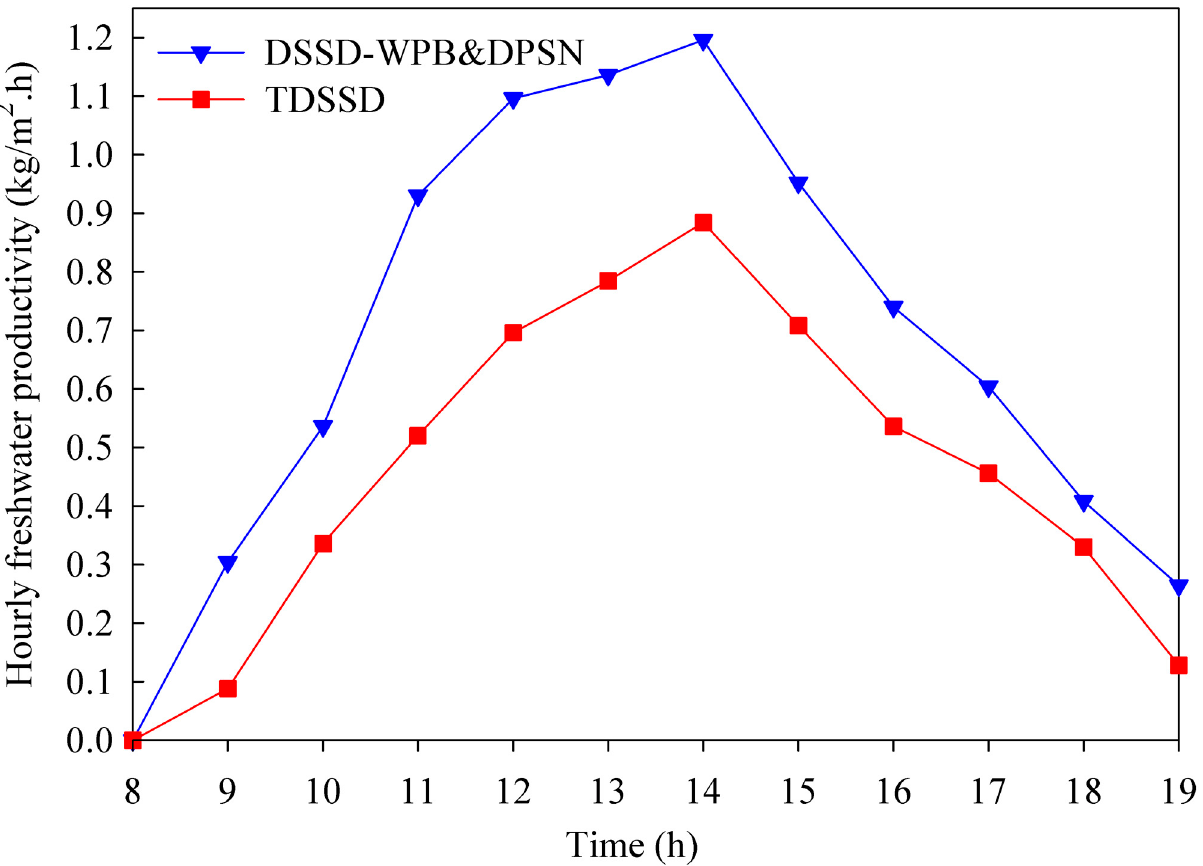
Figure 6. Time dependence: hourly distilled water yields for DSSD-WPB&DPSN and TDSSD. The cumulative distillation yields for the new DSSD-WPB&DPSN and TDSSD from 8:00 to 18:00 are presented in Figure 7. The measured findings clearly indicate that the modified DSSD with wick prismatic absorber basin and internal spaying nozzles has higher cumulative distillation yield than that of the traditional DSSD one, for the same reasons previously explained. It is concluded that the overall cumulative distillation yields are collected as 8.20 kg/m 2 day for the DSSD-WPB&DPSN and 5.48 kg/day.m 2 for the TDSSD at a fixed saline water depth of 2.0 cm.